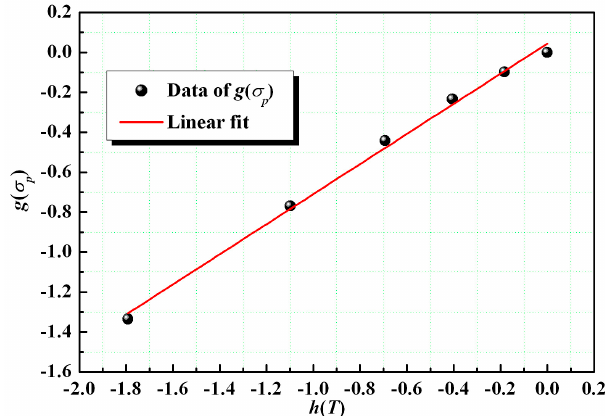
. ε = 1.0 × 10 − 3 s − 1 and T = 930~990 ◦ C.